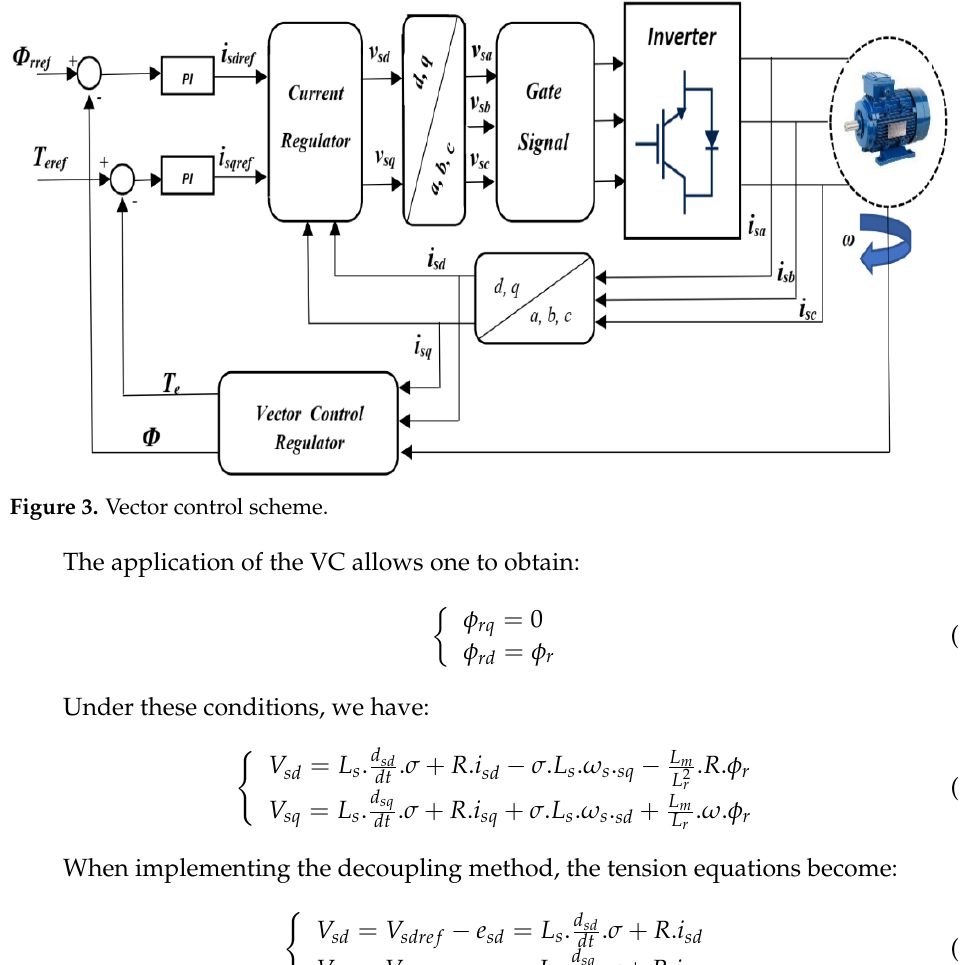
Figure 2. Space vector diagram of five-level inverter.